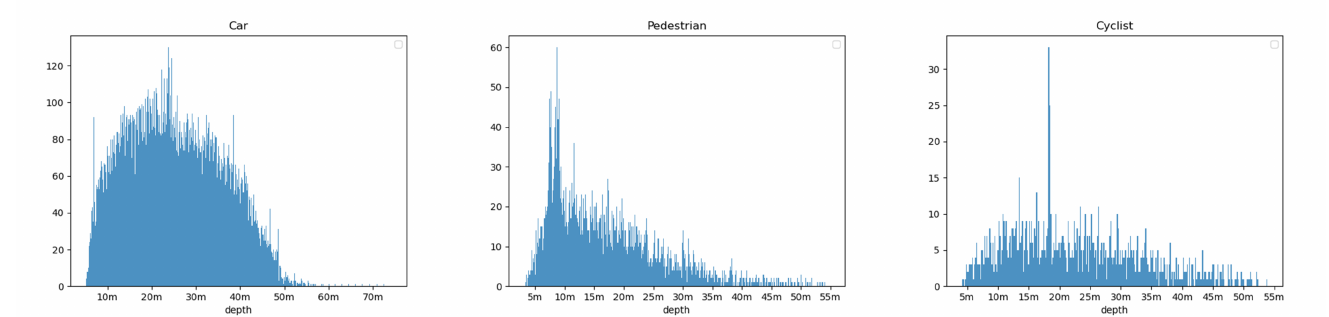
Figure 10. The histograms of the depth of the three classes in the KITTI training